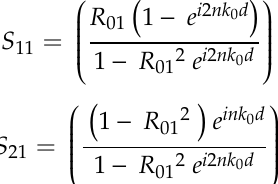
Figure 5. Transmission coefficients for different unit cell array structures.